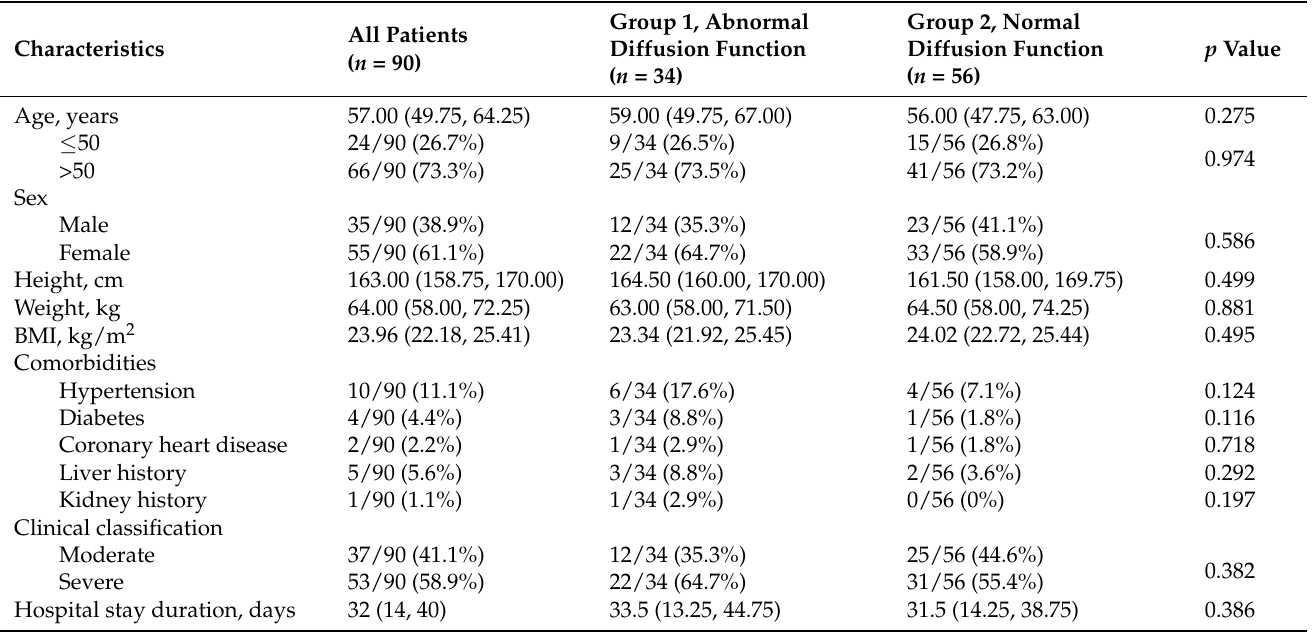
Figure 2. Flowchart of patient inclusion. Table 1. The demographics and clinical characteristics in COVID-19